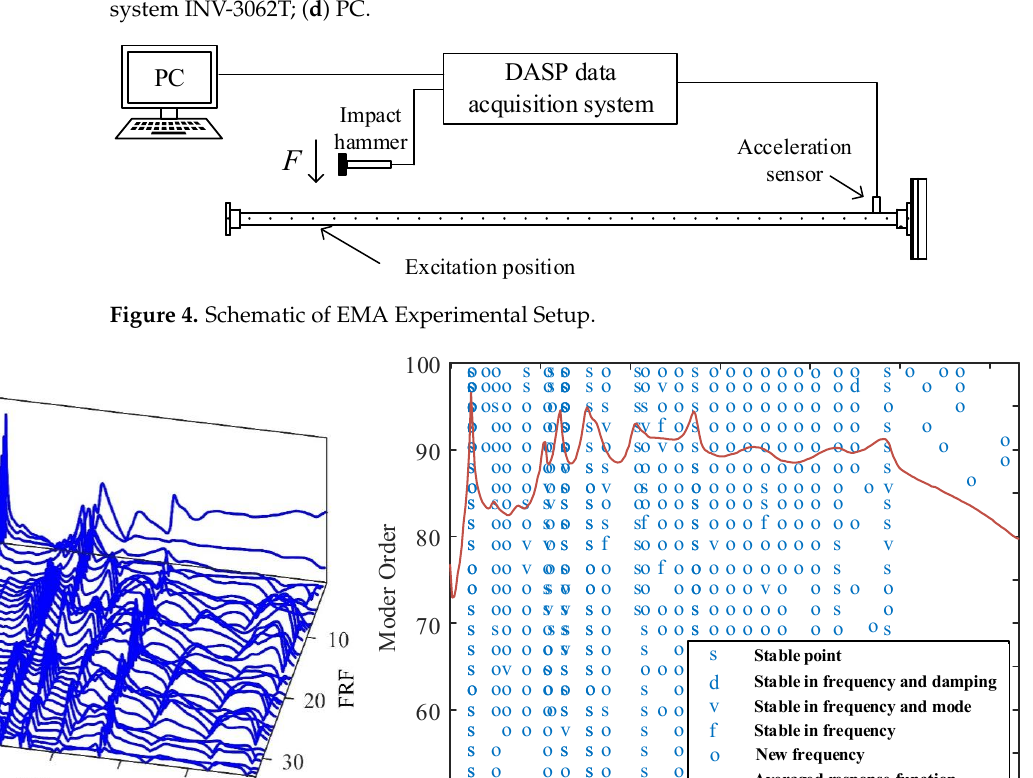
Figure 4. Schematic of EMA Experimental Setup.